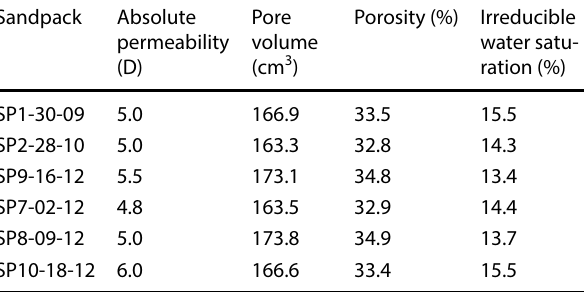
Table 6 Overview of petrophysical parameters of sandpacks used in this study